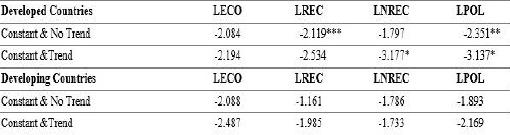
Table 5: CIPS Panel Unit Root Test Results